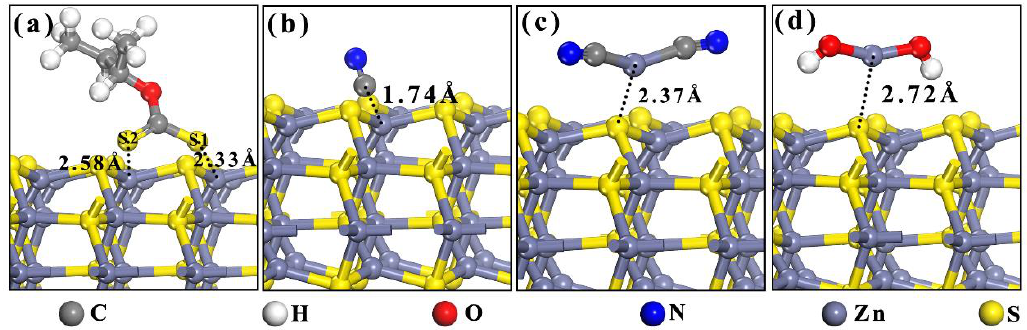
Figure 5. Adsorption models of ( a ) BX, ( b ) CN − , ( c ) Zn(CN) 2 , and ( d ) Zn(OH) 2 on the surface of sphalerite (110).